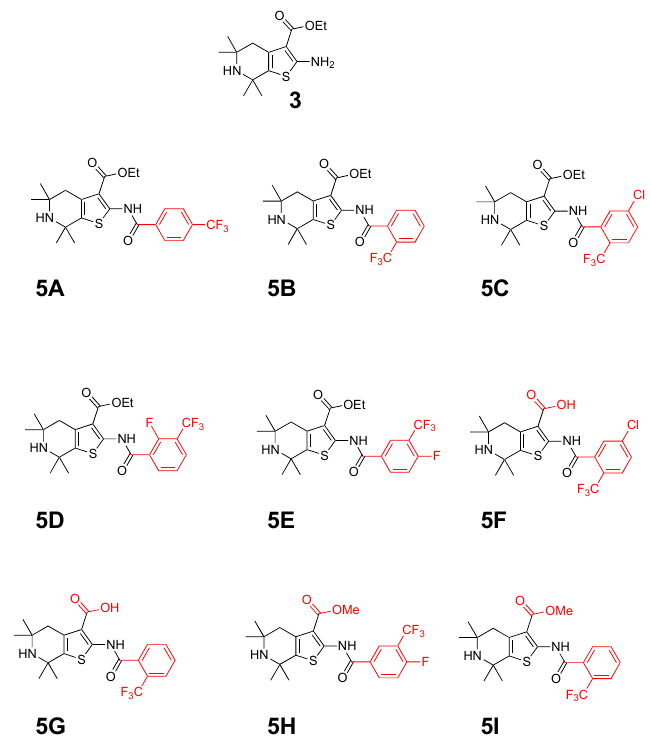
Figure 2. Chemical structures of the nine thiophene compounds.